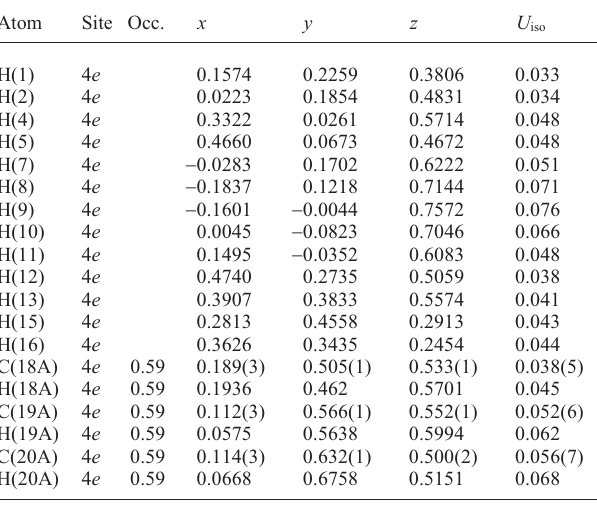
Table 2. Atomic coordinates and displacement parameters (in Å 2 )